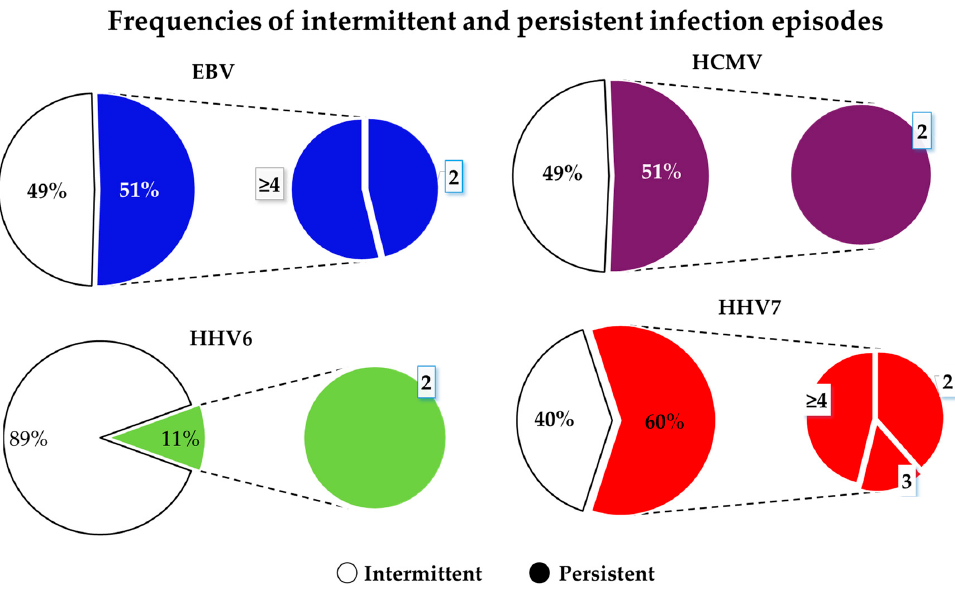
Figure 8. Plots showing frequency of intermittent and persistent infections. Large pie charts ( left ) show percentages of intermittent and persistent infections for each virus as indicated. Small pie charts ( right ) show proportions of 2, 3, and ≥ 4 sustained episodes of consecutive positive detection.